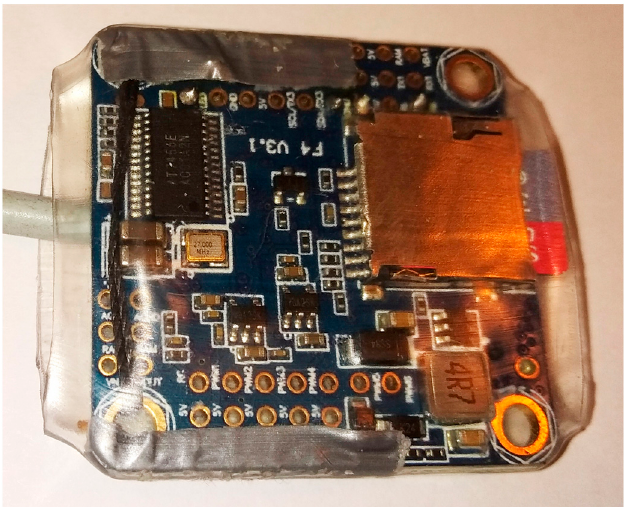
Figure 6. View of the cabled sensor secured by a transparent shrink tube, with a 32 GB micro-SD card in the slot for local recording.